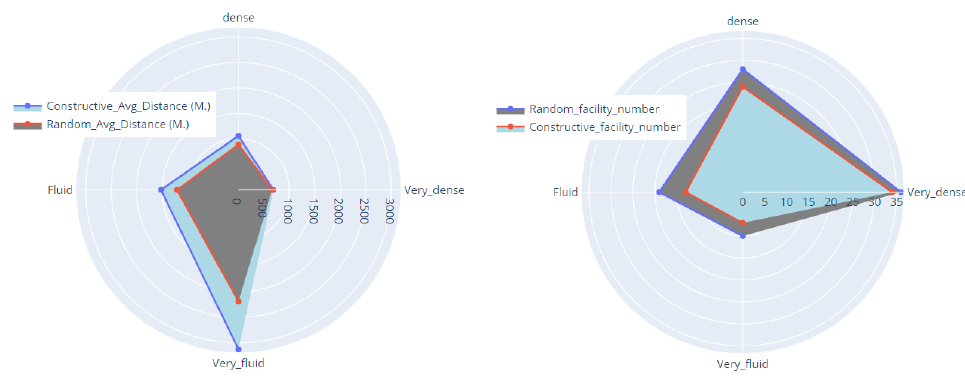
Figure 12. Performance of different